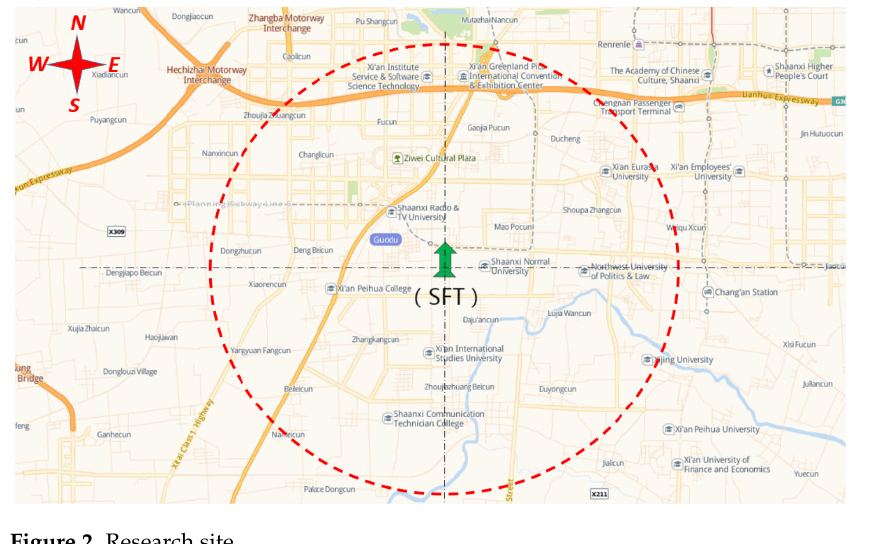
Figure 2. Research site.